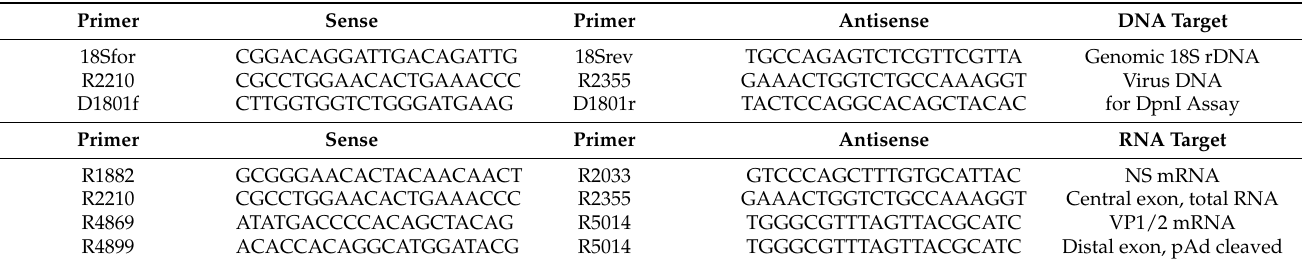
Table 1. Primer combinations used in the qPCR and qRT-PCR assays for the detection and quantitative evaluation of B19V nucleic acids. See also Figure S1 for primer location on B19V genome. Sense Primer Antisense DNA